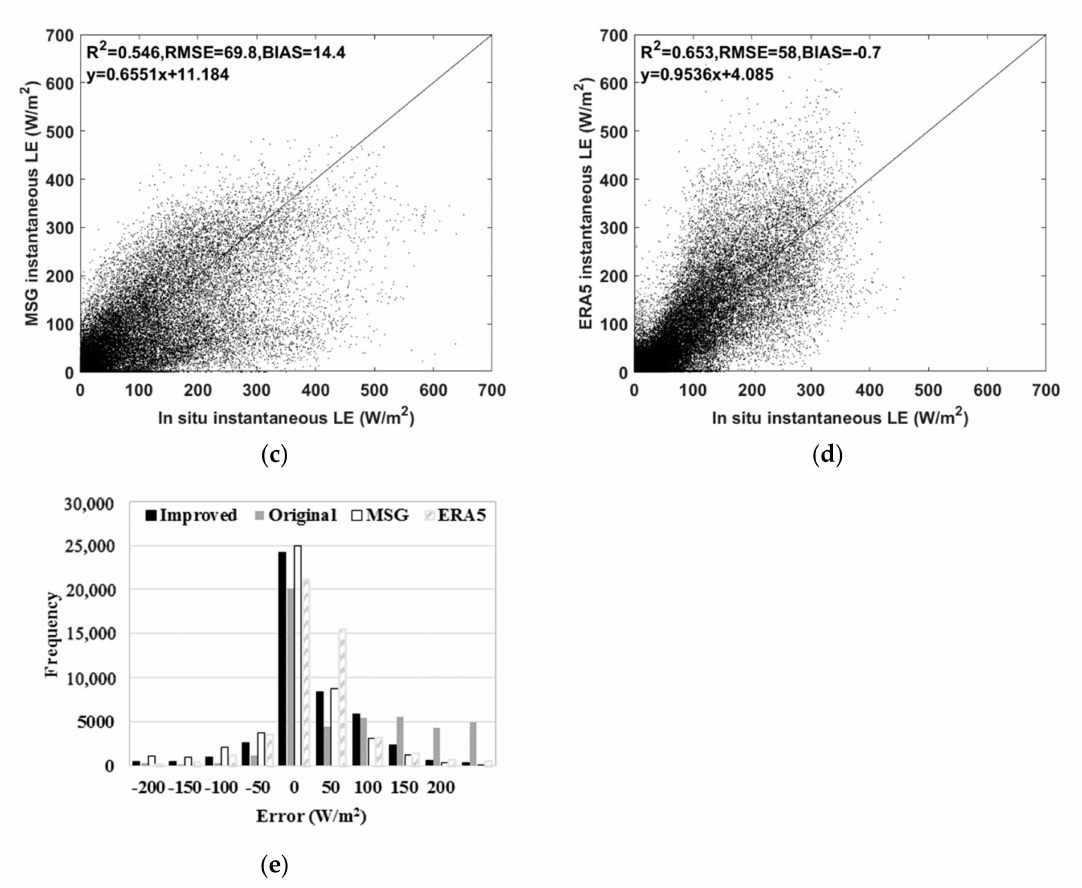
Figure 3. Comparisons of estimated instantaneous latent heat flux ( LE ) with in situ measurements from the FLUXNET2015 dataset: ( a ) improved method constrained by ETMonitor daily evapotranspiration (ET); ( b ) original method without constraint; ( c ) Meteosat Second Generation (MSG) ET (MET) product; ( d ) ERA5 ET data; and ( e ) their error frequency distribution